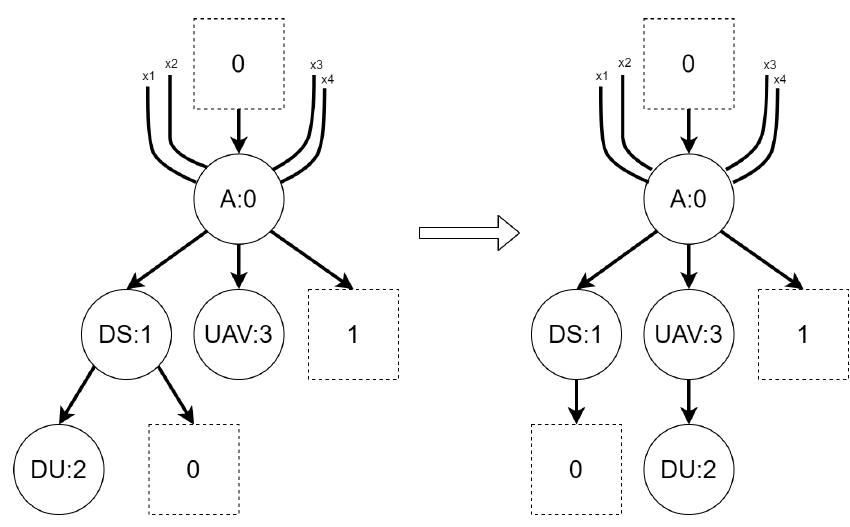
Figure 11. Reaction rule download data for scenario 2. Rationale: the rule is intended to allow a UAV to download information from an information